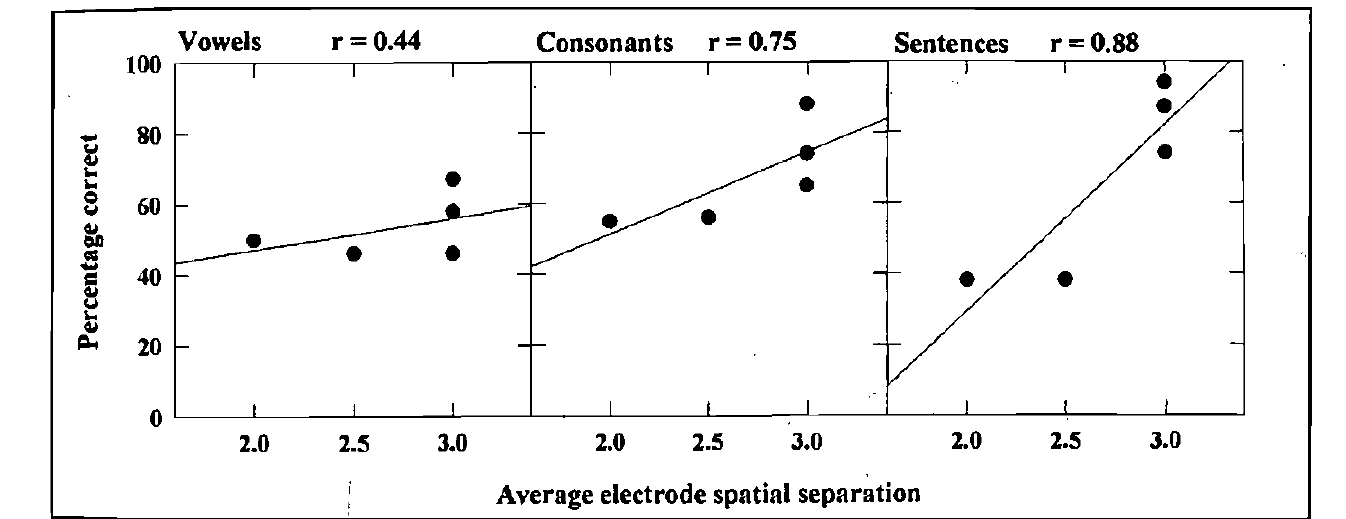
FIGURE 9. Speech perception as a function of average electrode spatial separation for subject REK. Linear regression lines are fitted through the data and correlation coefficients are given above each panel.